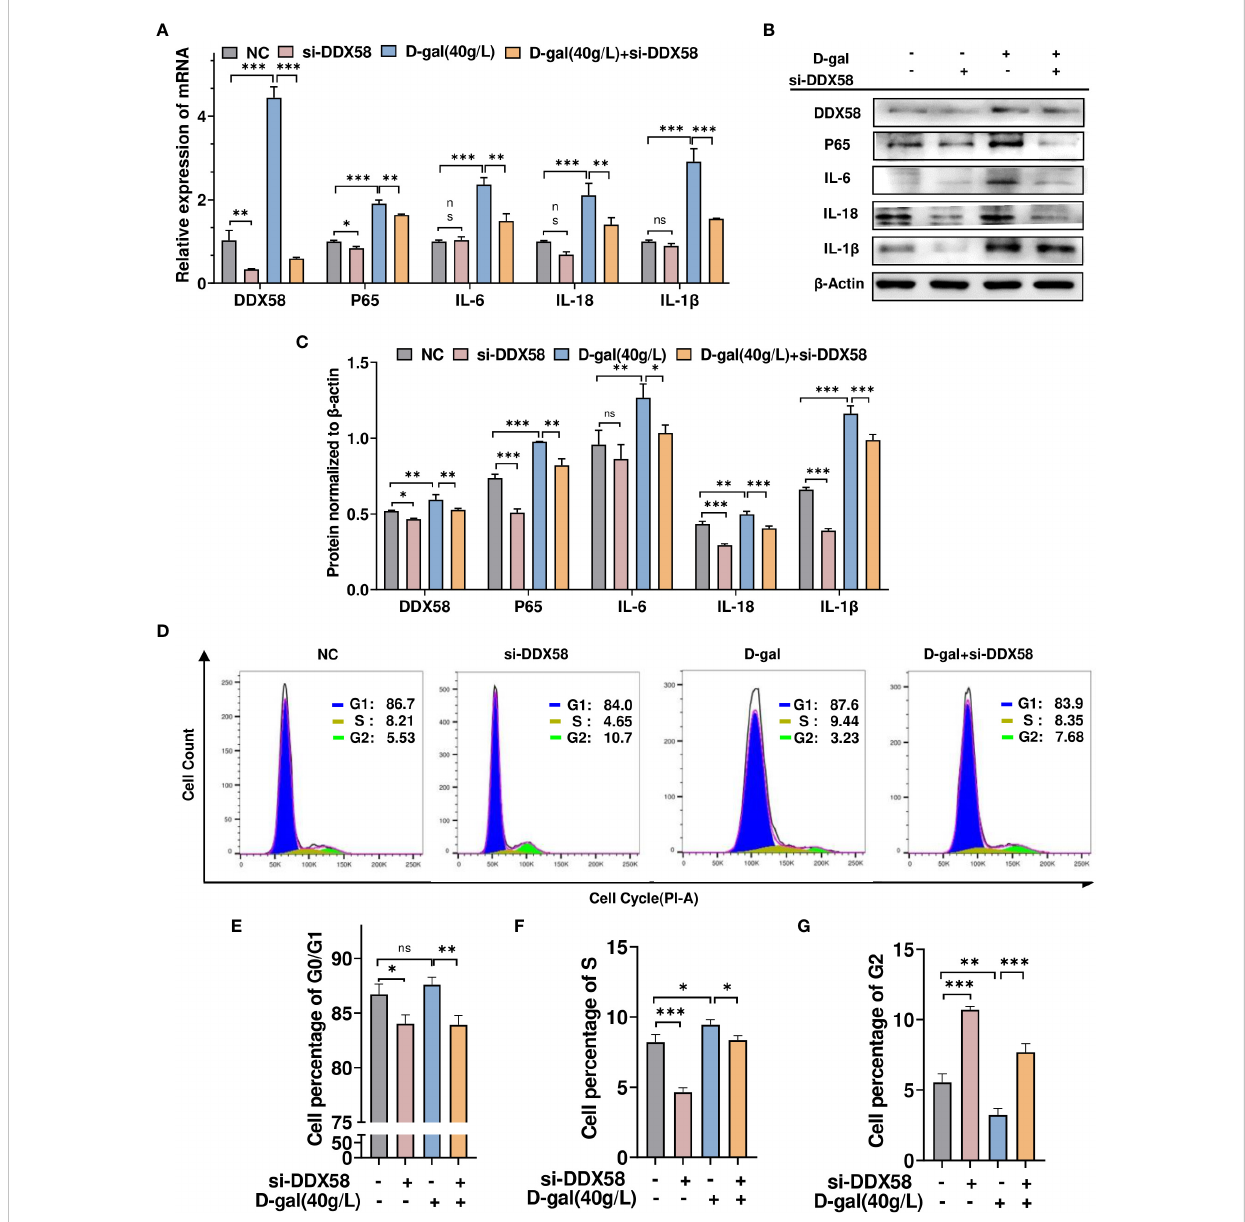
FIGURE 6 DDX58 is involved in D-gal-induced cell growth arrest and cellular in fl ammatory responses. (A) RT – qPCR and (B) Western blot analysis was used to detect DDX58, p65, IL-1 b , IL-18, and IL-6 expression in cells transfected with siRNA-DDX58 and D-gal alone or in combination. (C) The panel shows the grayscale analysis. (D) Flow cytometry analysis of the cell cycle in the four cell groups in (A) showed the percentage of cells at various phases of division. These graphs indicate the changes in (E) G0/G1, (F) S, and (G) G2 phases in different cell groups. * p < 0.05, ** p < 0.01, *** p < 0.001; ns indicates no statistical signi fi